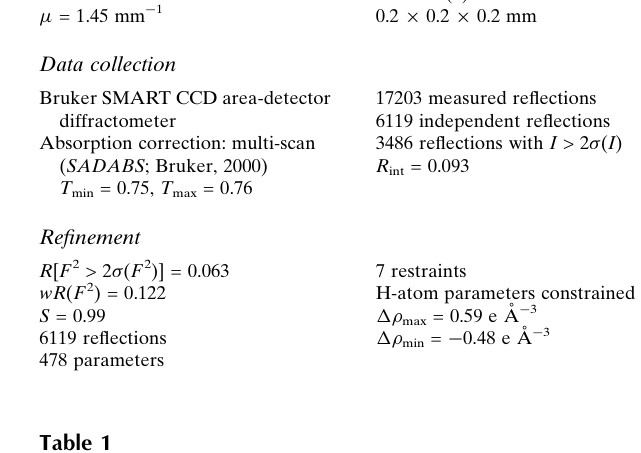
Hydrogen-bond geometry (A˚ , (cid:3) ).